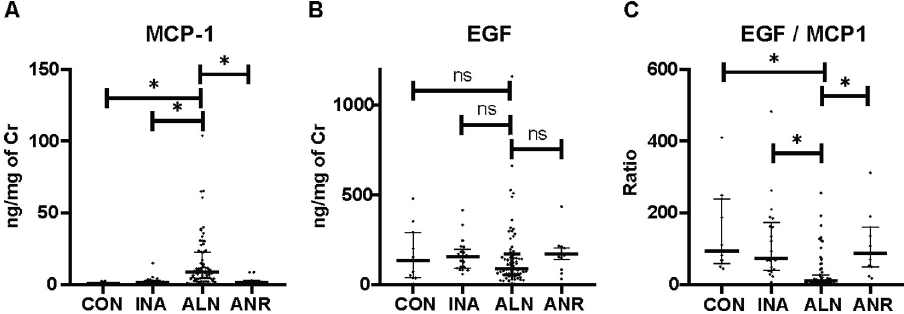
Fig 1. Urine cytokines in SLE patients and healthy controls. a) MCP-1, b) EGF and c) EGF/MCP-1. Active lupus nephritis (ALN), n = 69; Active non-renal (ANR), n = 21; Inactive SLE (INA), n = 21; and healthy controls (CON), n = 11). � p < 0.05. Cr,